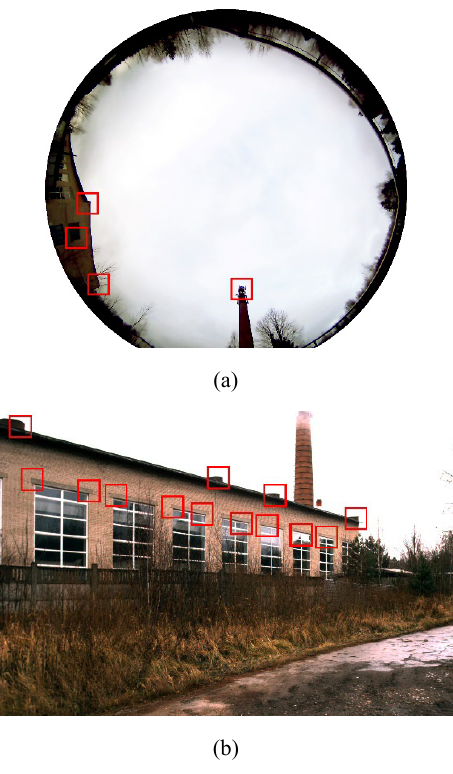
Figure 7 . Examples of images of the registering blocks of the VS layout. (a) Omnidirectional / panoramic cameras; (b) Stereo system (a frame from one of the cameras is shown). Objects that can be used as landmarks are marked with red